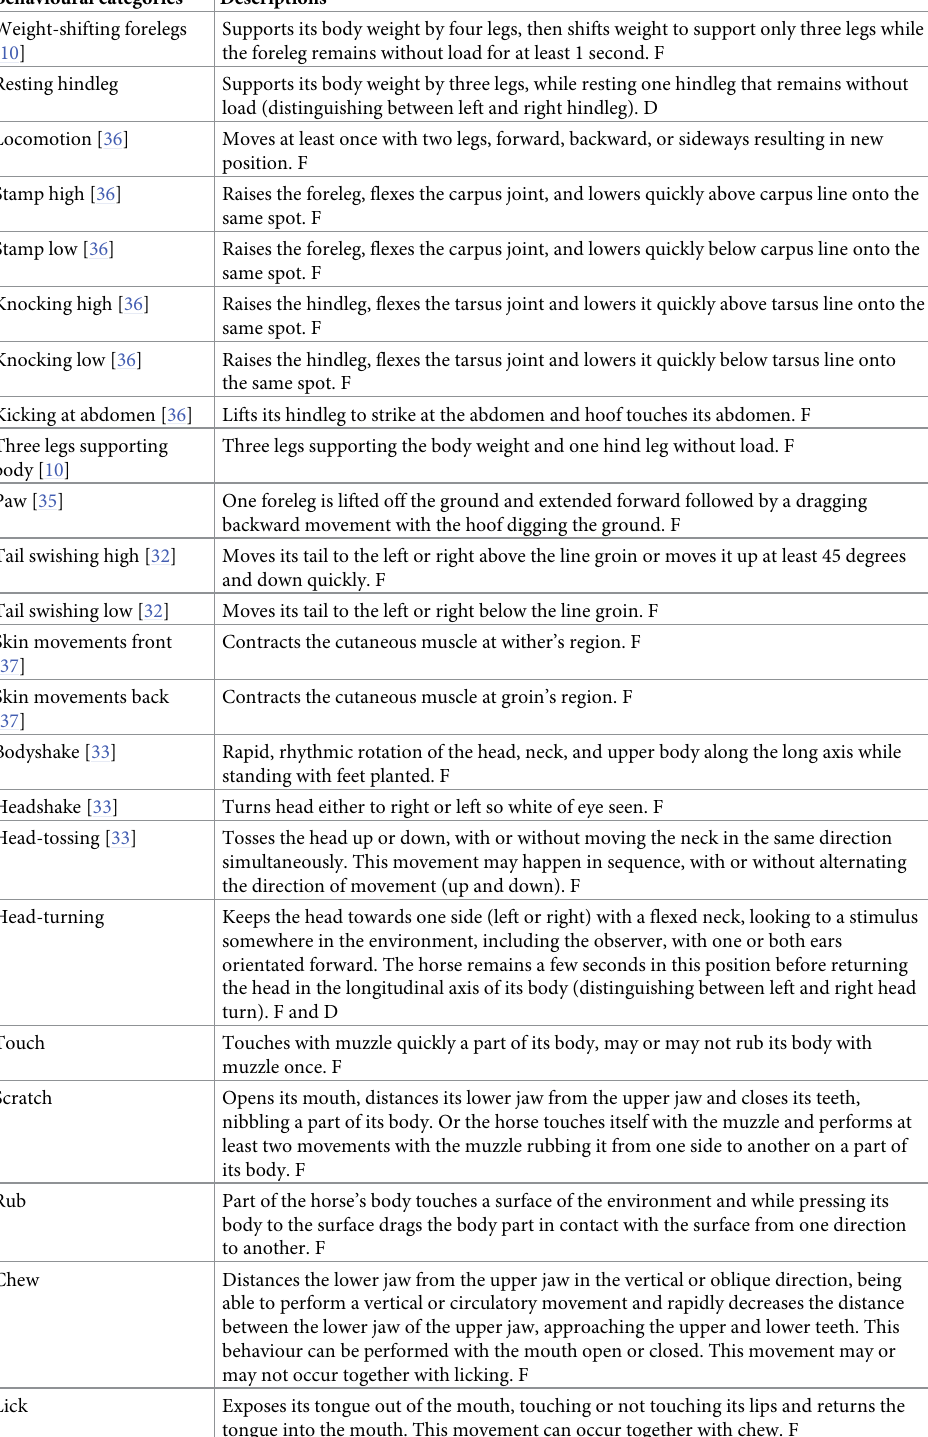
Table 3. Ethogram of the 34 other behaviour variables (adapted from [10, 32–37]) and respective recording method (F = frequency and D = duration; only for “head position” and “legs supporting body” was instantaneous sampling used, for the rest of the behavioural categories continuous sampling was